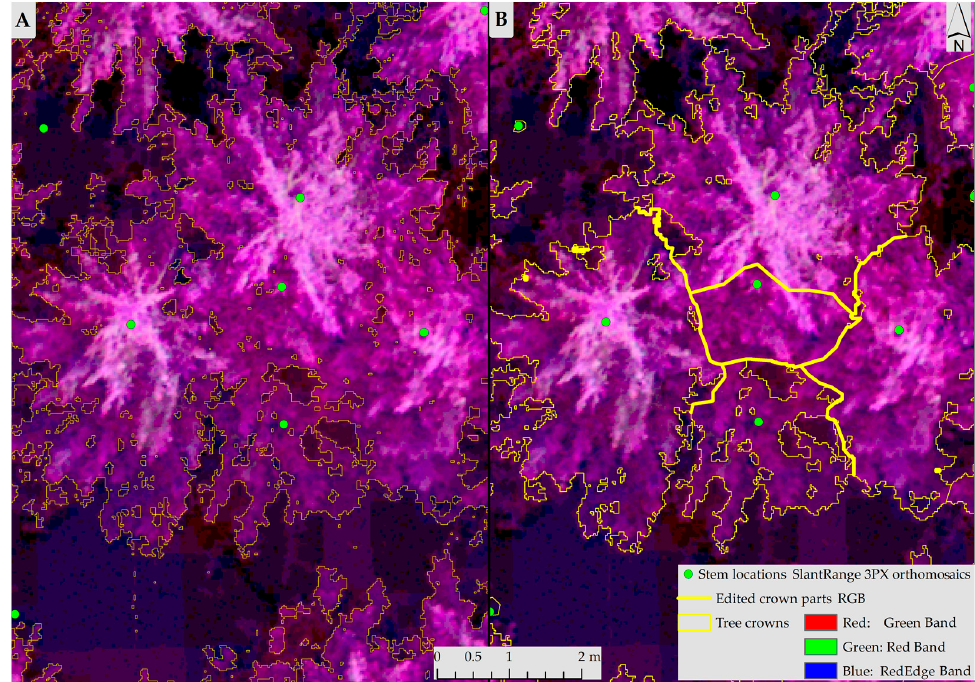
Figure 2. Detection and delimitation of individual tree crowns from the Isodata segmentation technique ( A ) Automatic crown classification; ( B ) Crowns after manual separation and deletion of features (bold yellow represents edited parts).